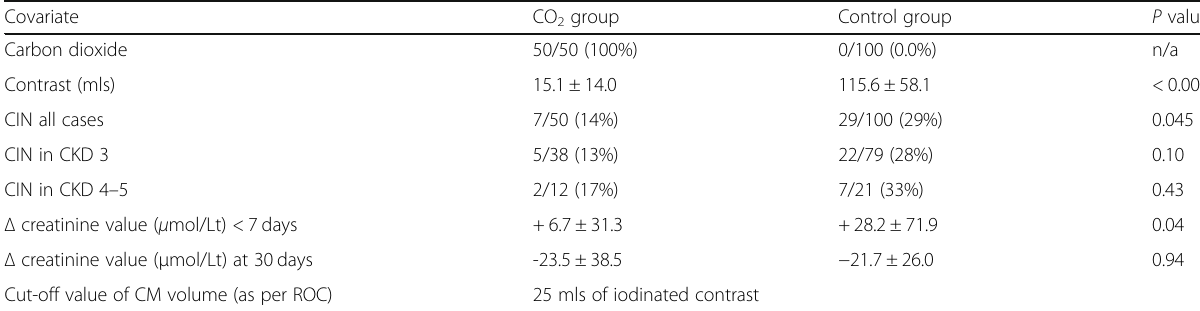
Table 2 Clinical outcomes